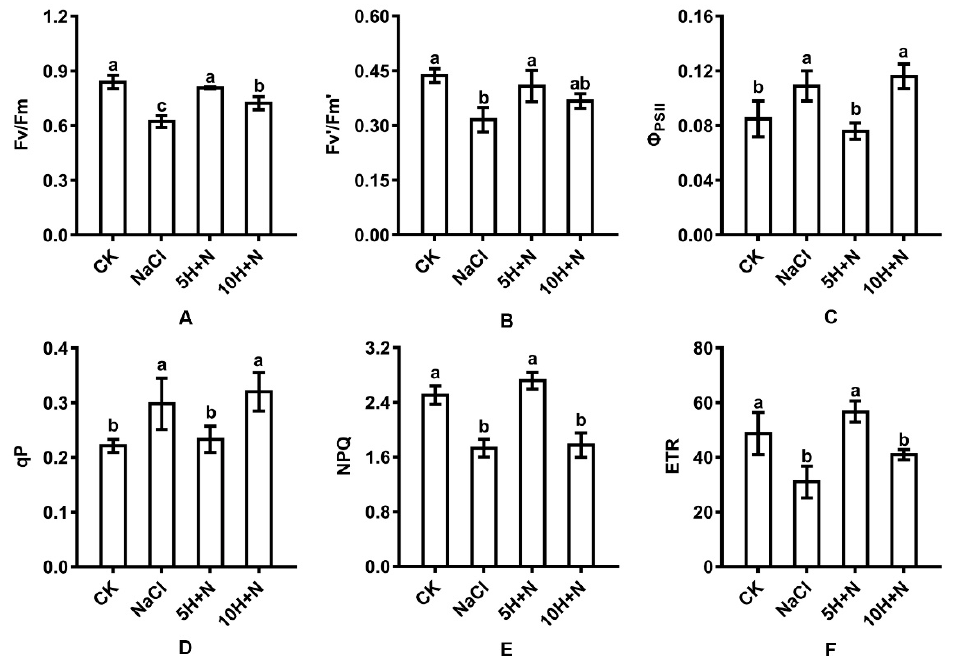
Figure 5. Effects of exogenous H 2 O 2 on Fv/Fm ( A ), Fv ′ /Fm ′ ( B ), Φ PSII ( C ), qP ( D ), NPQ ( E ), and ETR ( F ) of Tartary buckwheat under NaCl stress. CK: control, H 2 O foliar spray + H 2 O irrigation, NaCl: H 2 O foliar spray + 150 mmol·L − 1 NaCl irrigation, 5H + N: 5 mmol·L − 1 H 2 O 2 foliar spray + 150 mmol·L − 1 NaCl irrigation, 10H + N: 10 mmol·L − 1 H 2 O 2 foliar spray + 150 mmol·L − 1 NaCl irrigation. Fv/Fm: PSII maximum photochemical efficiency, Fv ′ /Fm ′ : effective quantum yield, Φ PSII : actual photochemical efficiency of PSII, qP: photochemical quenching coefficient, NPQ: non-photochemical quenching coefficient, ETR: effective electron transfer rate. All values are expressed as mean ± SD. According to Duncan’s multiple comparisons, different letters represent significant differences among different treatments ( p < 0.05).